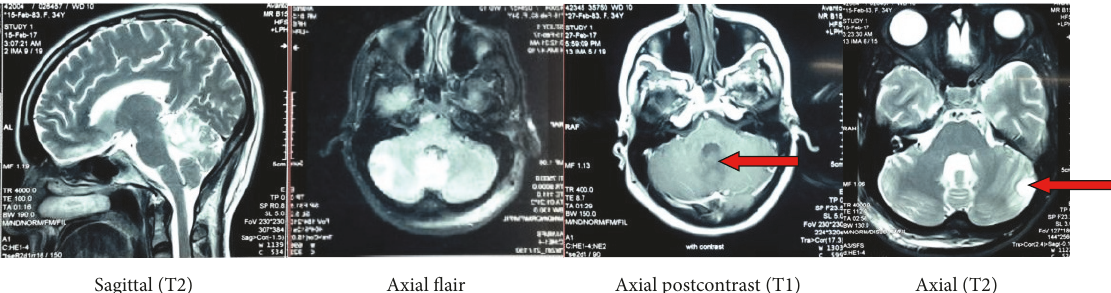
Figure2:Multiplecysticlesionsincerebellumwithenhancingneuralnodulesandmildperilesionaloedemasuggestiveofhemangioblastomas (central and peripheral lesions are indicated by red arrows).